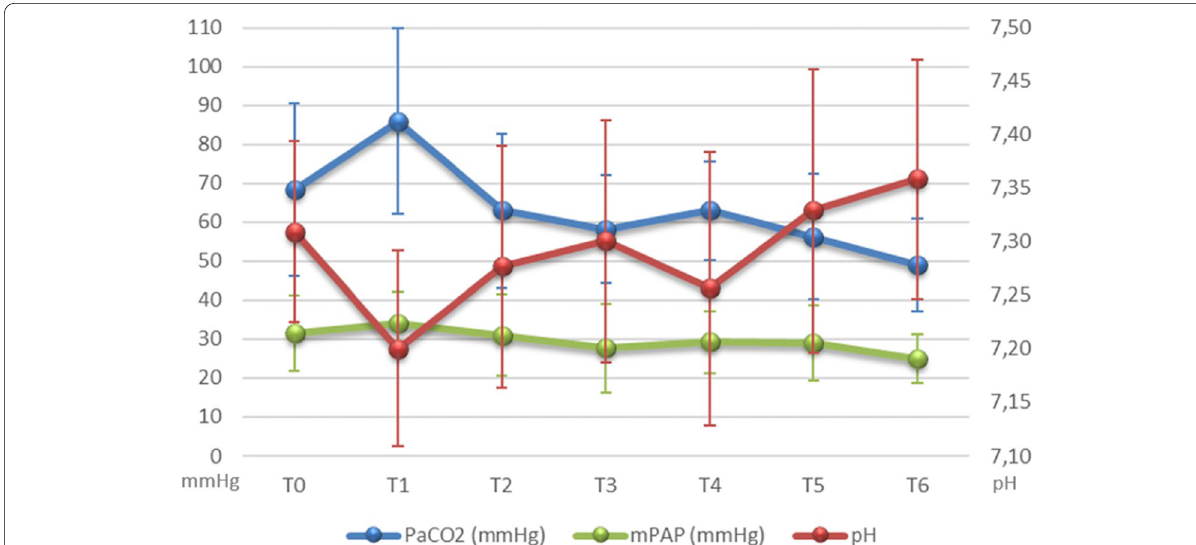
Fig. 2 Changes in PaCO2, mPAP and pH in the 15 patients undergoing ECCO2R. Legend: PaCO2 Arterial Carbon Dioxide Partial Pressure; mPAP = mean pulmonary artery blood pressure; T0 double lung ventilation at the beginning of LT; T1 single lung ventilation (preclamping of the = = = pulmonary artery); T2 clamping of the pulmonary artery; T3 after 40 min from clamping; T4 after 90 min from clamping; T5 = = = from clamping; T6 declamping of the pulmonary artery; primary axis (on the left) values of PaCO2 and mPAP in mmHg; secondary axis (on the = = right) values of pH. All values are reported as mean and standard deviation. ECCO2R was started between T1 and T2 and continued until the end = of the